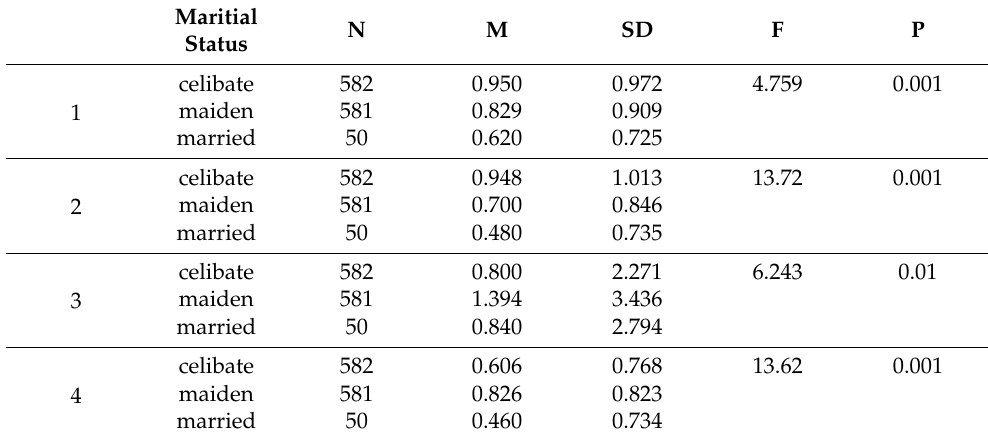
Table 2. ANOVA one way: sentimental categories and addiction symptoms.